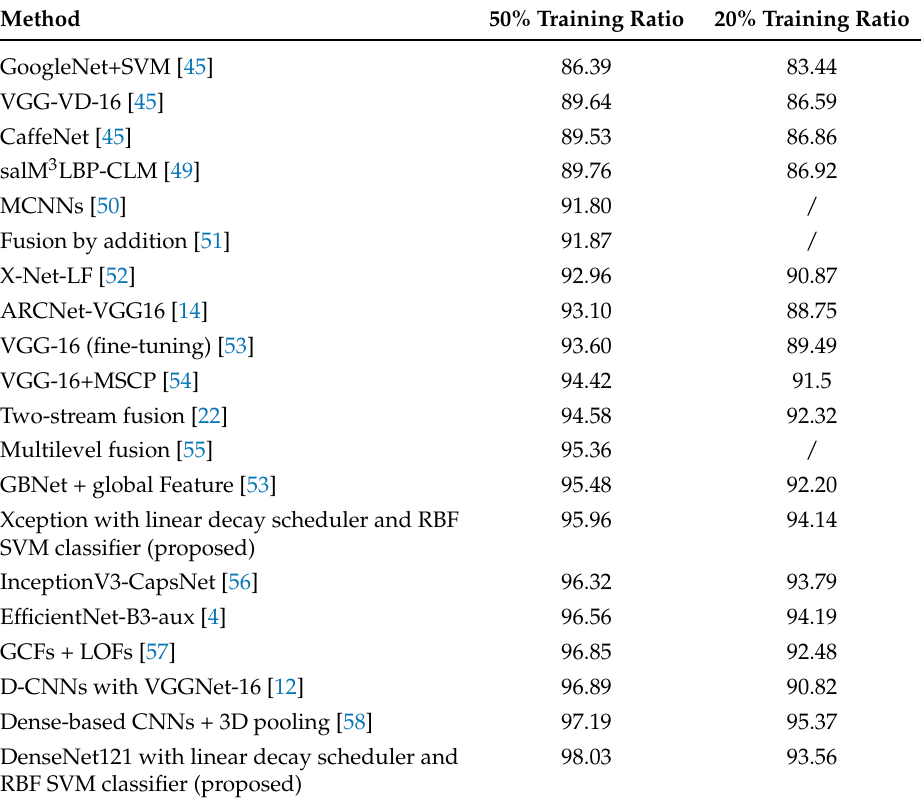
Table 3. Overall accuracy (%) of the proposed method compared to reference methods with 50% and 20% of the AID data set as a training set. For our method, we selected the best results obtained for the two training ratios, and report them in bold. Methods are ordered in ascending order by their performance on the 50% training